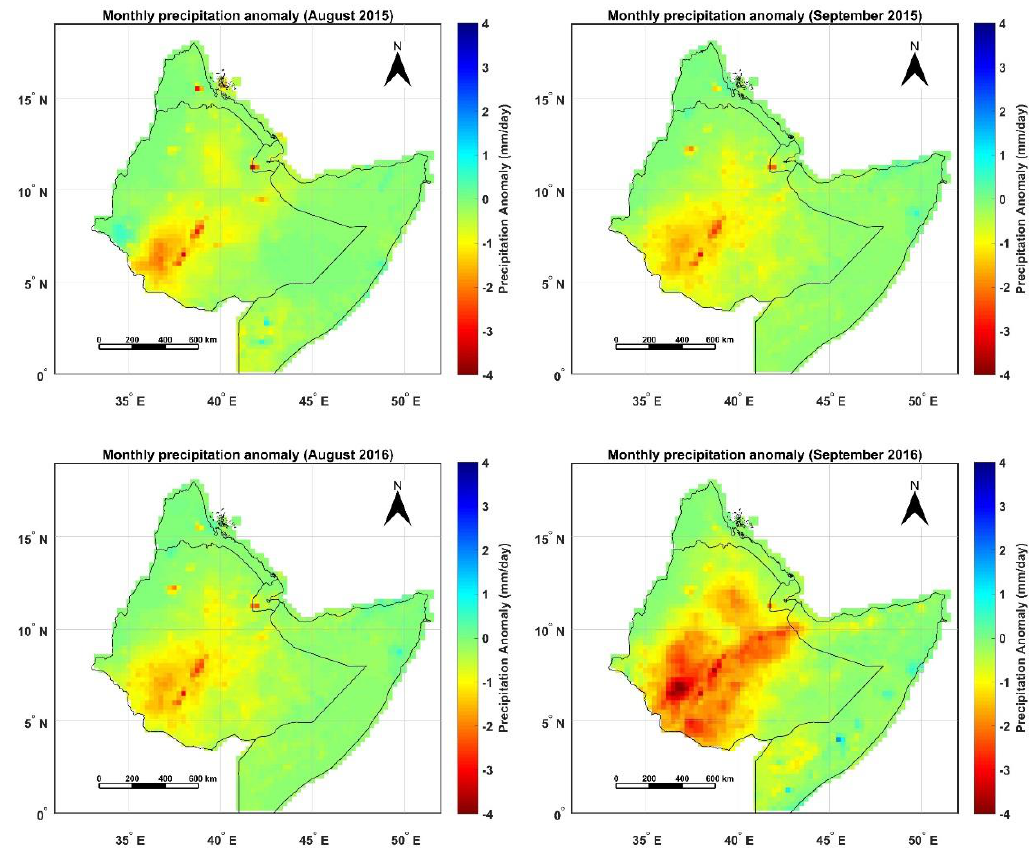
Figure 5. Monthly precipitation anomalies indicating extreme drought in the HOA during August and September in the years 2015 and 2016, especially in the agricultural areas of Ethiopia.